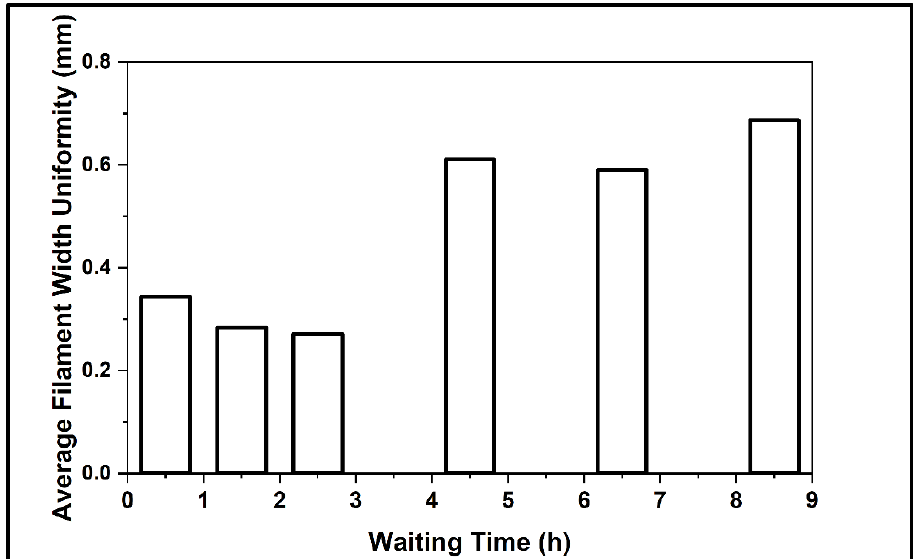
Figure 15. Effects of waiting time on filament width uniformity.